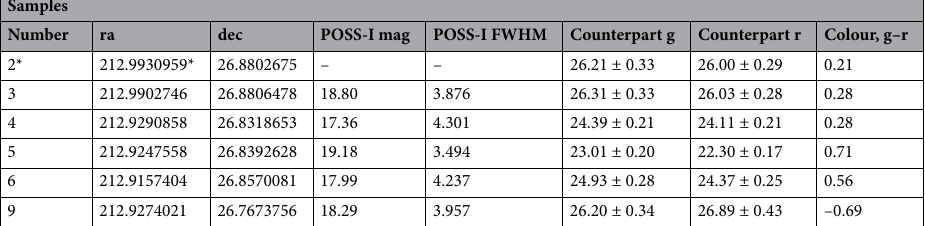
Table 1. Coordinates of simultaneous transients. We display the coordinates and magnitudes of the multiple transients that are covered by the GTC/OSIRIS images, including their counterparts. We see that 6 out of the originally 9 points are covered by the images. When two stars, like object 2 and 3, are too close to each other, the photometry code (that calculates Gaia r magnitudes) fails to detect one of the transients in the POSS-I image, which means we have no photometric information. These are marked with a star (*). Removing outliers with FWHMs larger than 10 pixel in the sample, the average seeing is about 4.8 + / − 0.8 pixel for all objects in the field. Finally, we show the g and r magnitudes (AB) for the closest